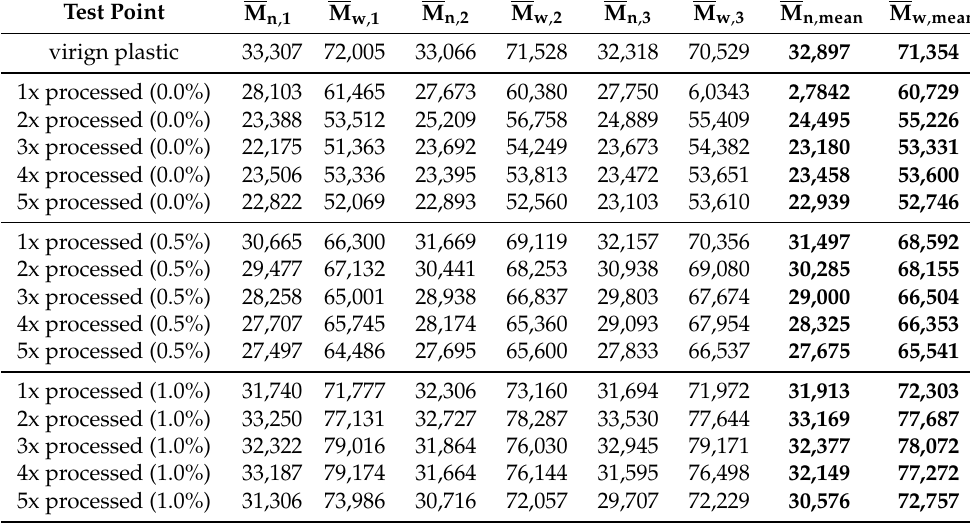
Table A2. List of the molar masses of all measurements (values in